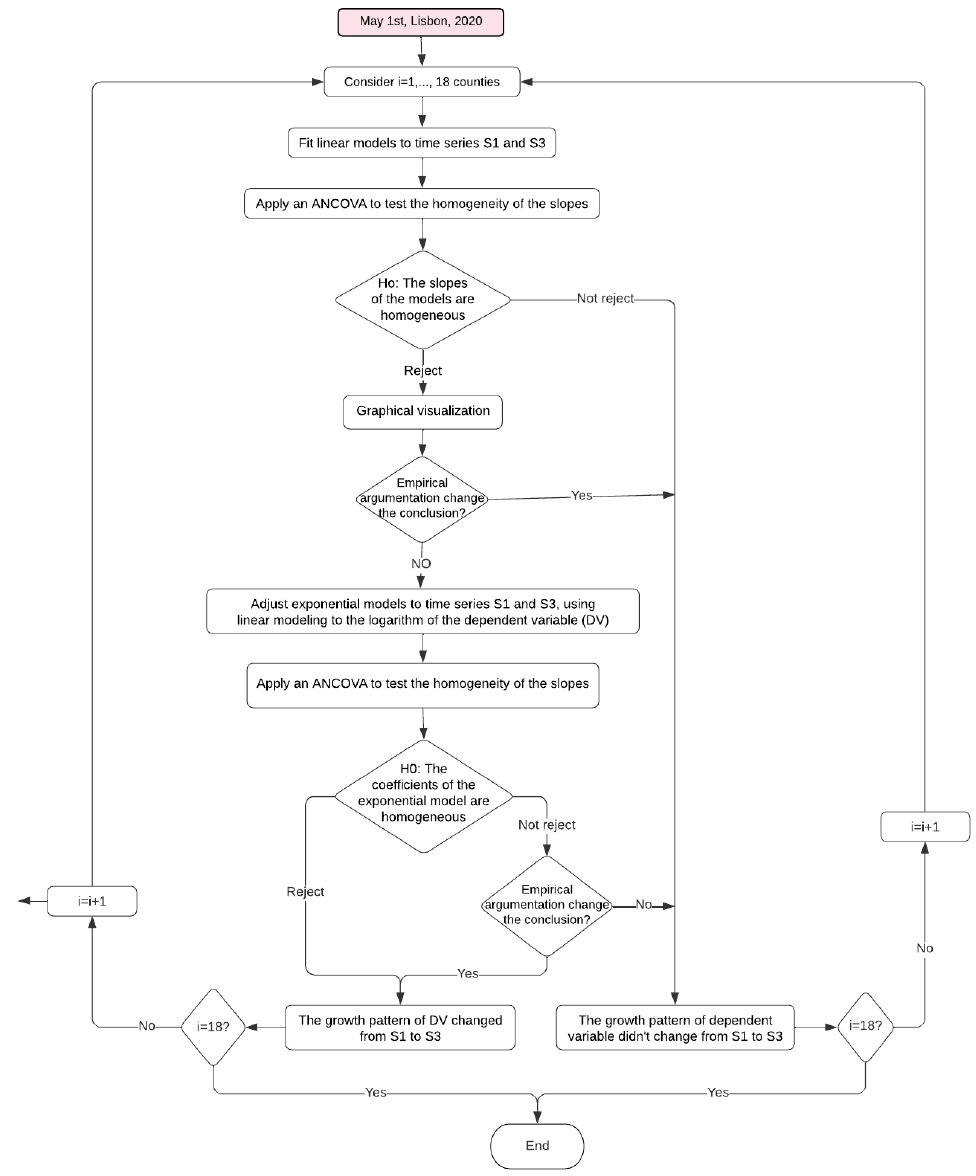
Figure 1. Flowchart illustrating methodology implemented in article for analyzing data from AML